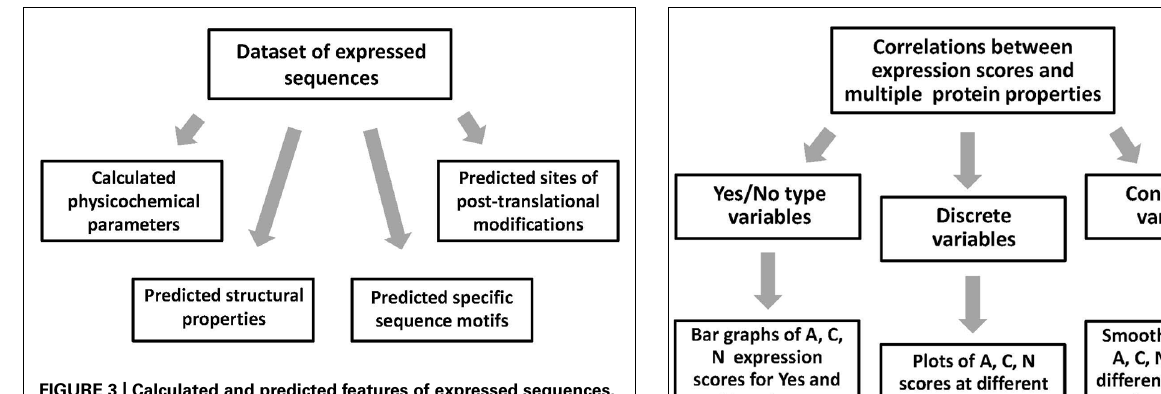
FIGURE 3 | Calculated and predicted features of expressed sequences. Various parameters and properties of the amino acid sequences in the expression dataset can be classified into four major types. Protein features are calculated or predicted using existing bioinformatics algorithms and tools.